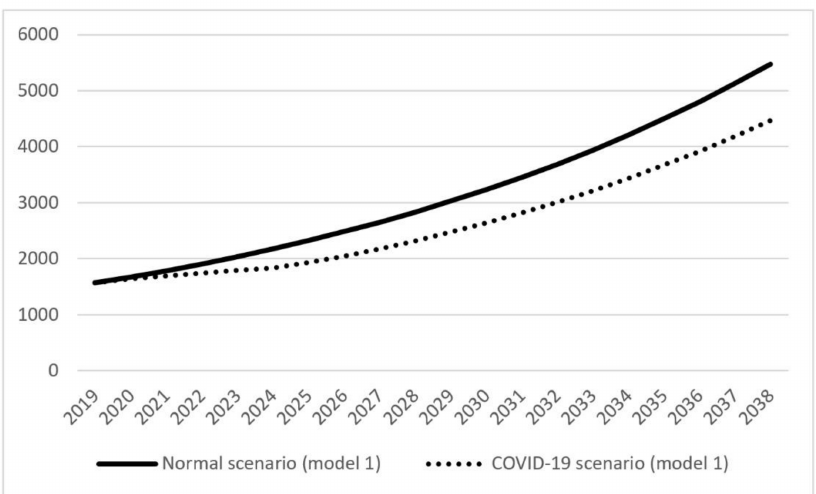
Figure 6. Forecast total energy demand for model 1 (petajoules). Note: We calculated the ex ante errors (i.e., upper and lower limits of confidence interval) for the forecast total energy demand under the business-as-usual scenario. In percentage terms, the maximum deviation was consistent and ranged from 3.6 to 3.7% for the upper level and − 3.7 to − 3.6% for the lower level. The trend graphs are presented in Appendix A Figure